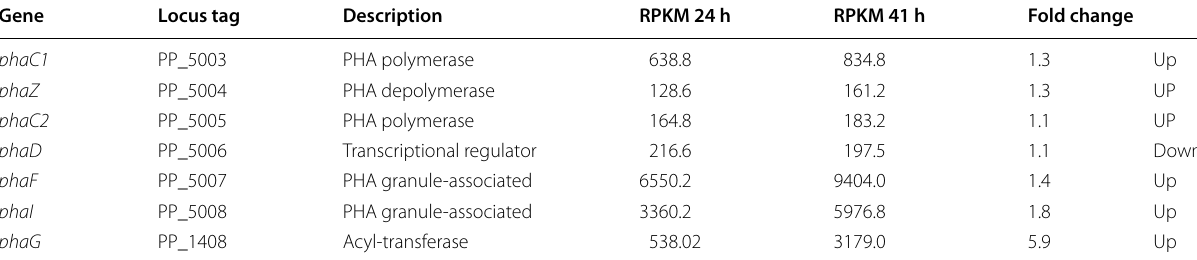
Table 3 Differences in pha genes transcription between exponential growth (24 h) and stationary phase (41 h) expressed in RPKM